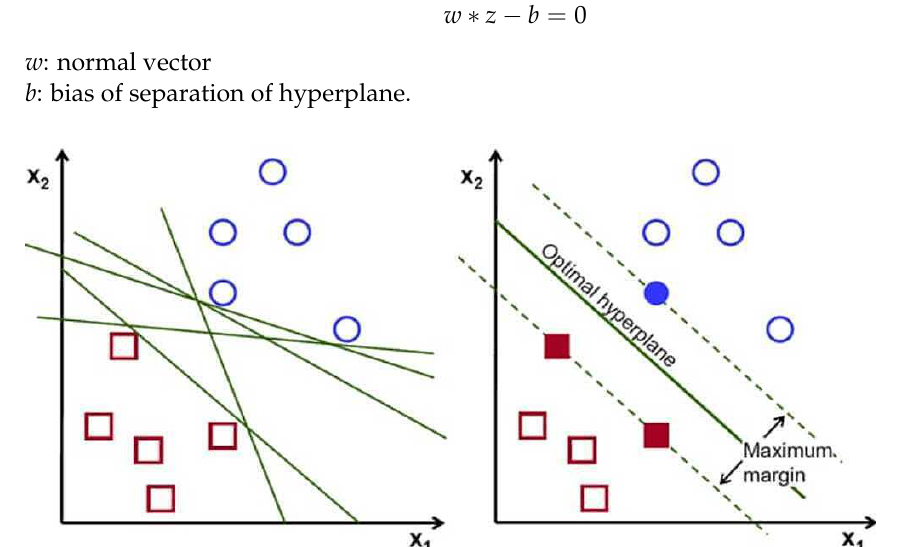
Figure 2. Support Vector Machine algorithm with the construction of different hyperplanes that separates the different classes. The most optimal hyperplane is the one that maximizes this separation.